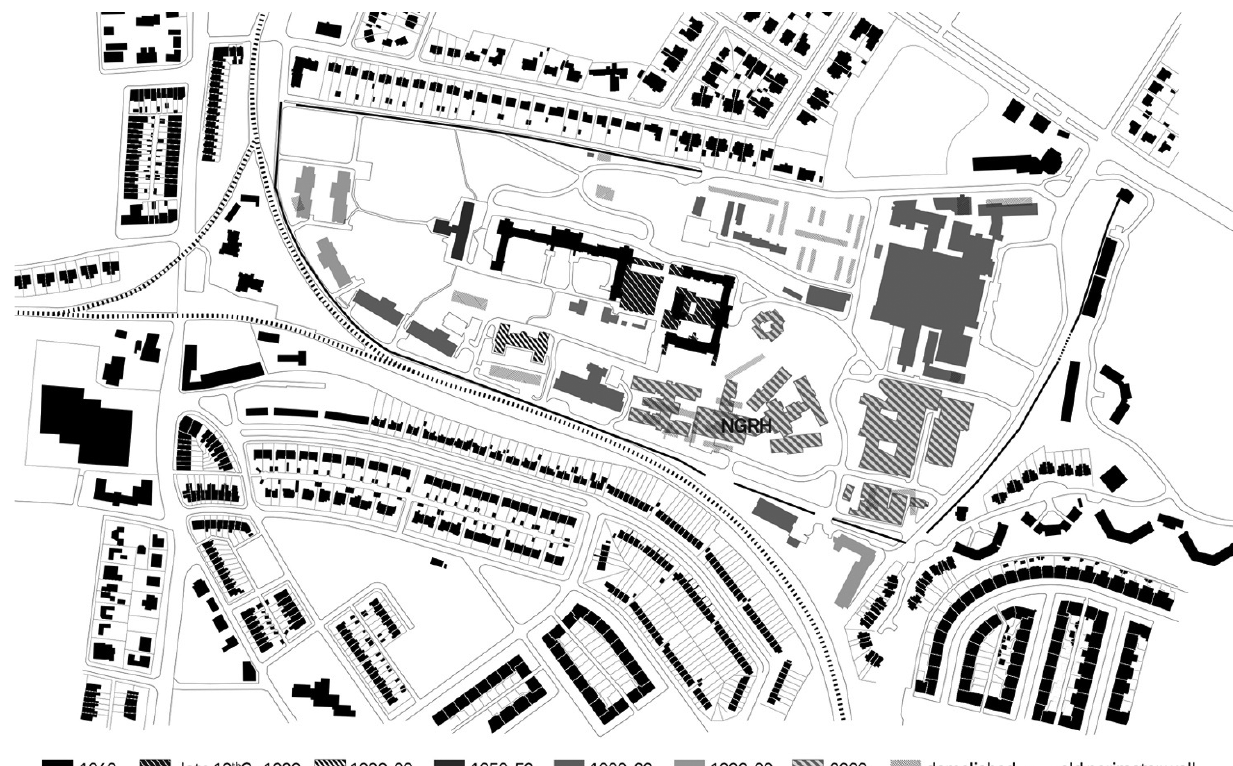
Figure 3. Site plan over Gartnavel Hospital Campus as it looks today is located amidst residences, businesses and other civic facilities. Since the construction in 1843 of the ‘old asylum’ on the hill it has been reworked and extended, as well as being supplemented by new wards, units and treatment centres trailing. One of the most recent developments is the new psychiatric clinic, New Gartnavel Royal Hospital (NGRH) and with its opening in 2008 the last patients moved down from the asylum on the hill. Note: Site plan by Andrea Gimeno